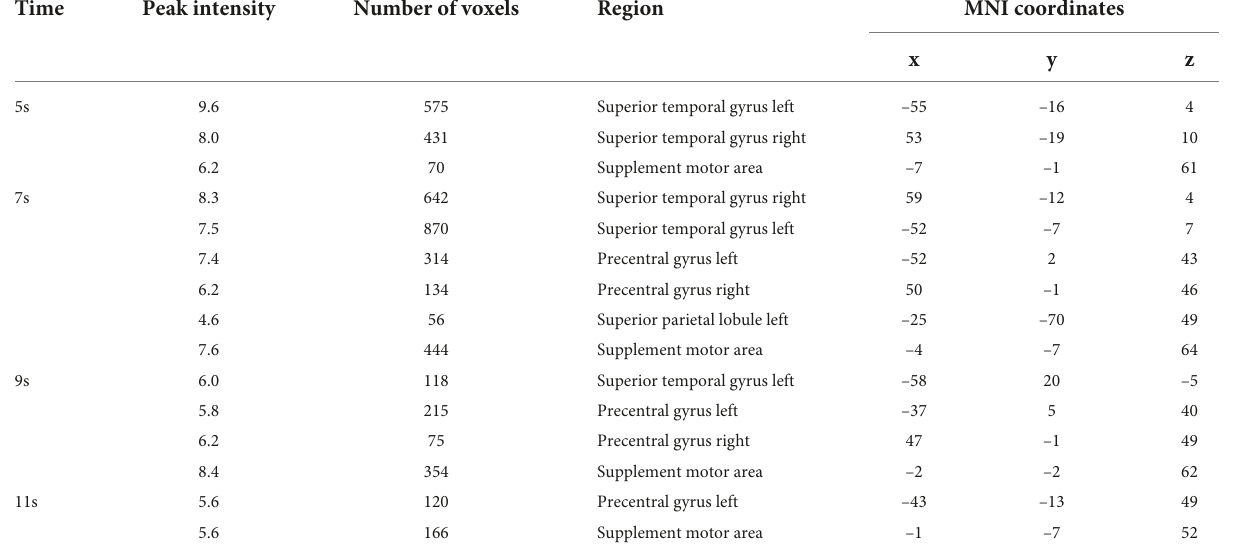
TABLE 2 Results of SC-MVPA ( Figure 3 left). Time Peak